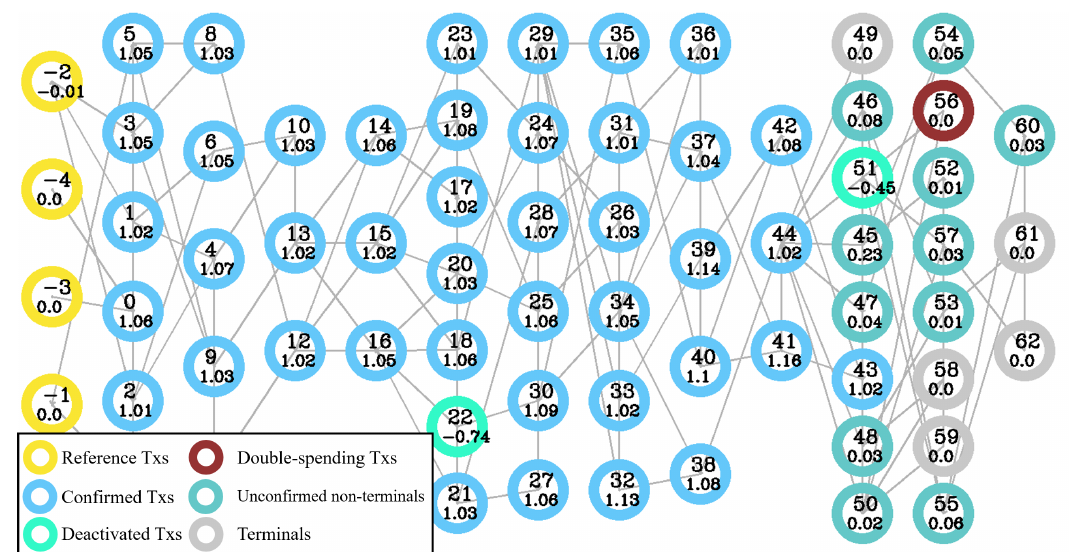
Figure 6. PowerGraph consensus algorithm